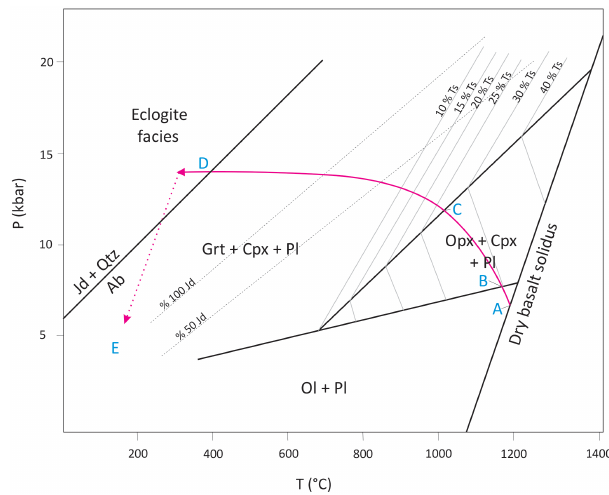
Figure 4. P – T grid indicating univariant equilibria crossed during cooling to produce the sequence of reactions in Fig. 1 (after Griffin,